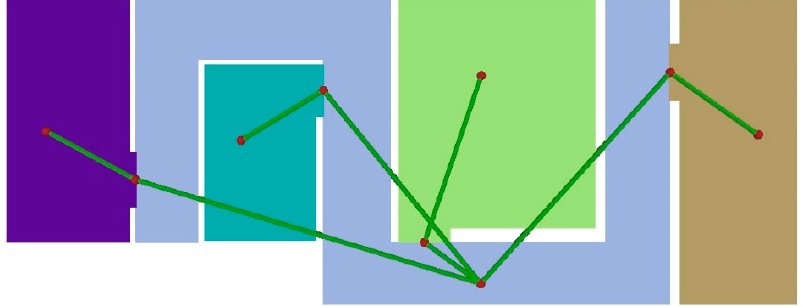
Figure 4. Node-relation structure and entrance (NRSE) navigation network with red nodes and green connections.